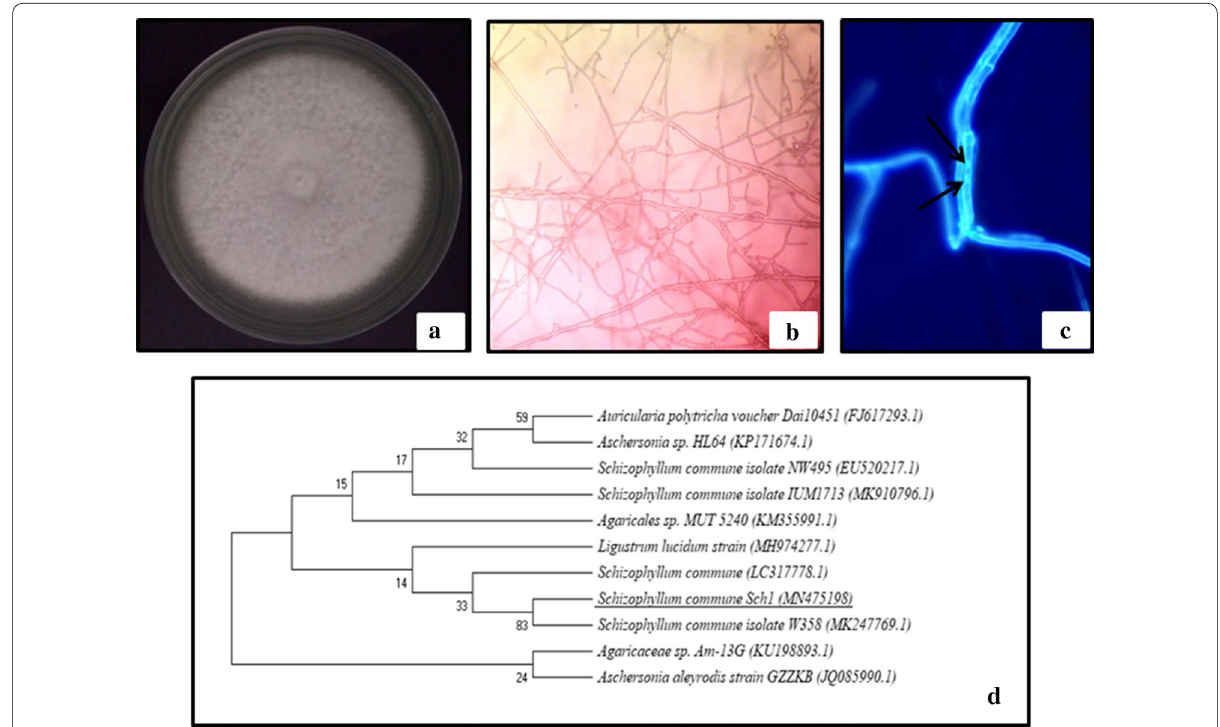
Fig.1 S. commune (Sch1) a colony morphology on PDA. b microscopic view (40X) c hyphae stained with DAPI under fluorescent microscope (100X). d ITS1-5.8S rDNA-ITS2 gene sequence based phylogenetic tree showing the taxonomic position of S. commune (Sch1). Phylogenetic analysis consisted of 11 nucleotide sequences. The evolutionary history was inferred using the Neighbor-Joining method. The optimal tree with the sum of branch length 1.58935111 is shown. All ambiguous positions were removed for each sequence pair. There were a total of 649 positions in the final dataset. Evolutionary analyses were conducted in MEGA